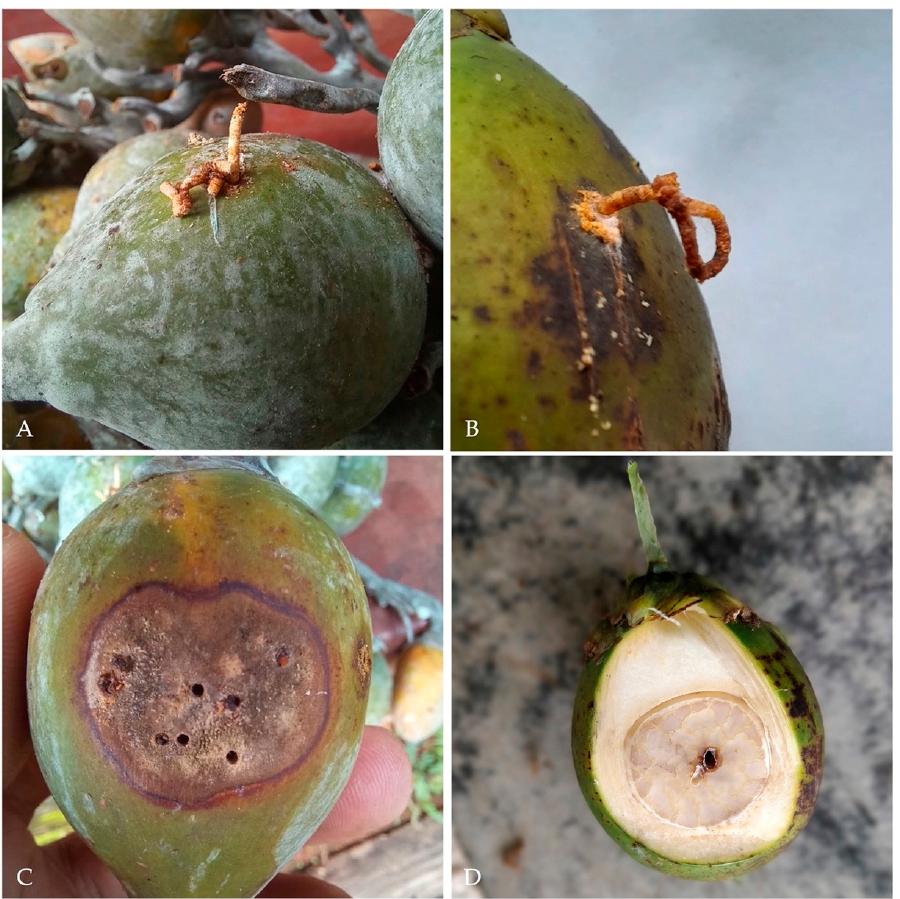
Figure 3. Areca nuts showing symptoms of the attack by Xylosandrus crassiusculus . ( A , B ) nut showing the typical frass noodle produced by the boring activity of the beetle; ( C ) nut presenting multiple entrance holes in association to a dark staining of the exocarp; ( D ) longitudinal section illustrating one Xylosandrus crassiusculus piercing through the nut kernel .